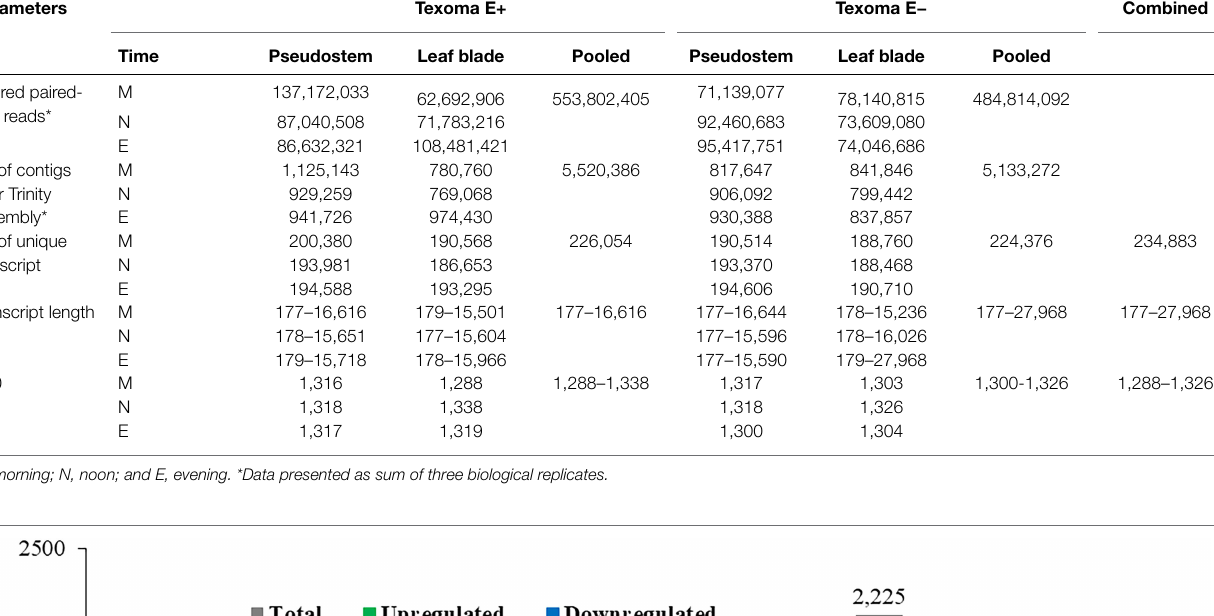
TABLE 1 | Assembly and annotation of the transcriptome data obtained from short read Illumina sequencing of Texoma endophyte positive (E+) and endophyte negative (E−) tissues under cold stress in the natural field environment.